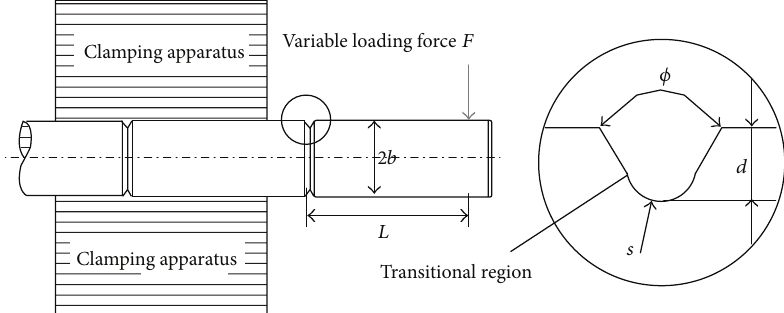
Figure 1: Schematic diagram of bar loading and V-shaped notch.